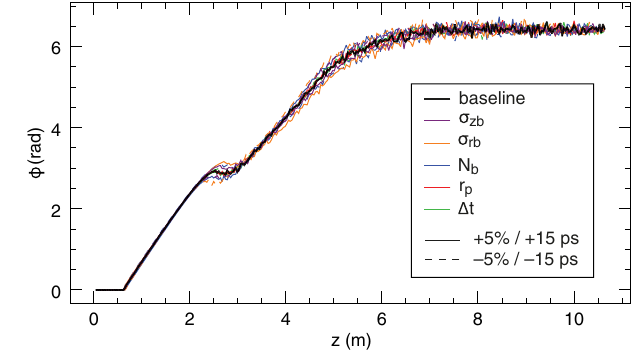
FIG. 7. Evolution of the local phase shift of E z with respect to the seed along the propagation distance z at ξ ≈ − 1 . 5 σ zb for different parameter